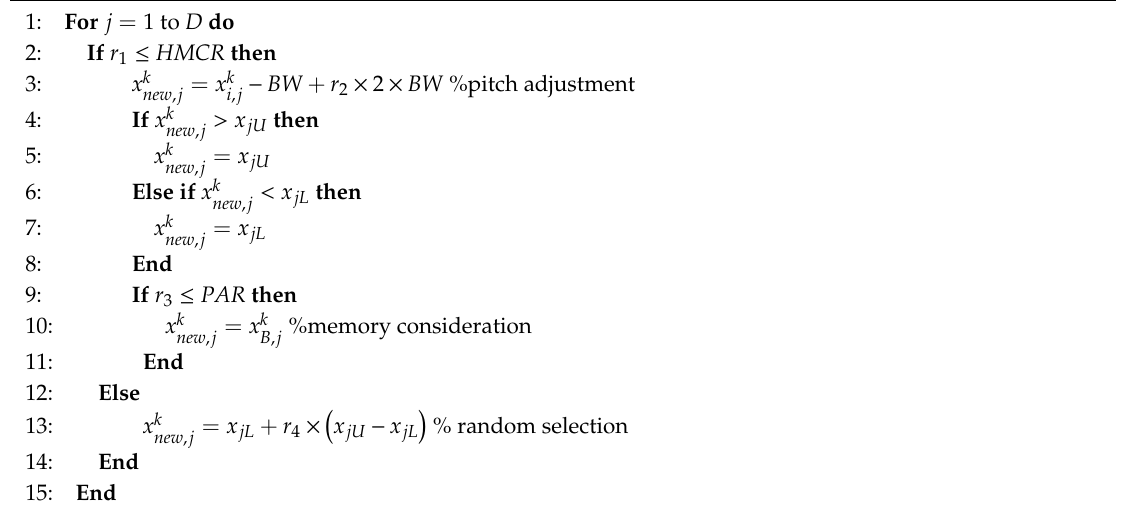
Algorithm 2 The Improvisation of New Harmony in SGHS